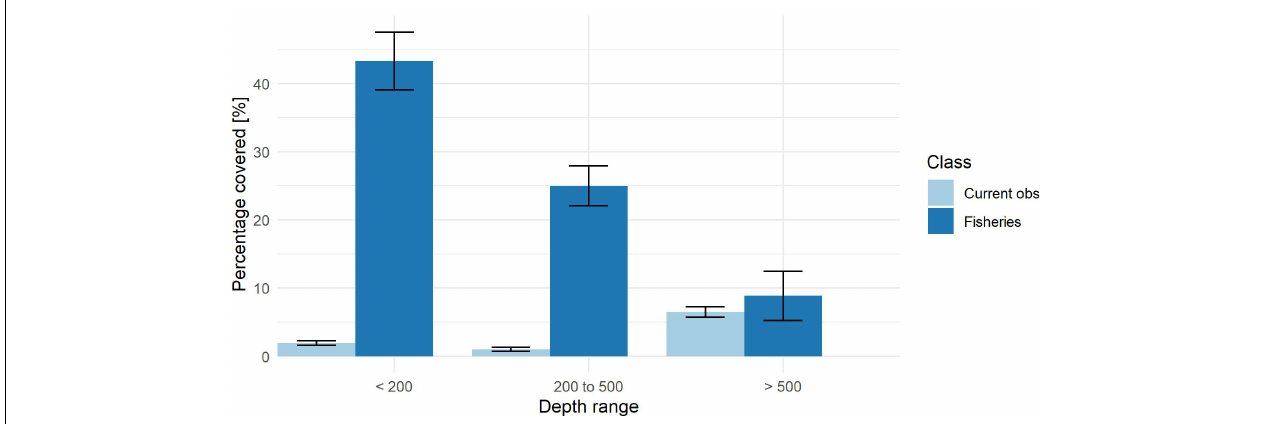
FIGURE 8 | The North Atlantic region monthly mean sub-surface observation and fishing coverage per depth category.